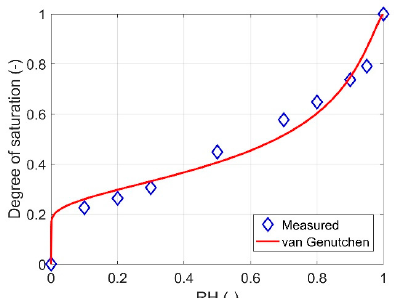
Figure 1. The desorption isotherm for the studied material. The isotherm was measured by DVS (data taken from [36]) and fitted by van Genutchen equation (Equation